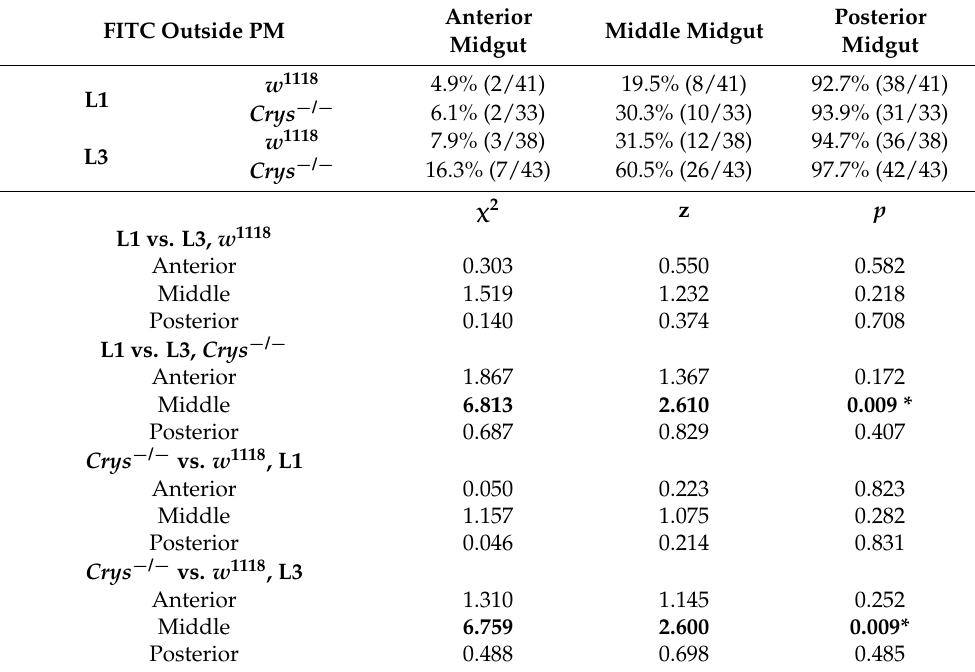
Table 2. The middle midguts of old Crys − / − larvae is more often permeable to DCV-sized